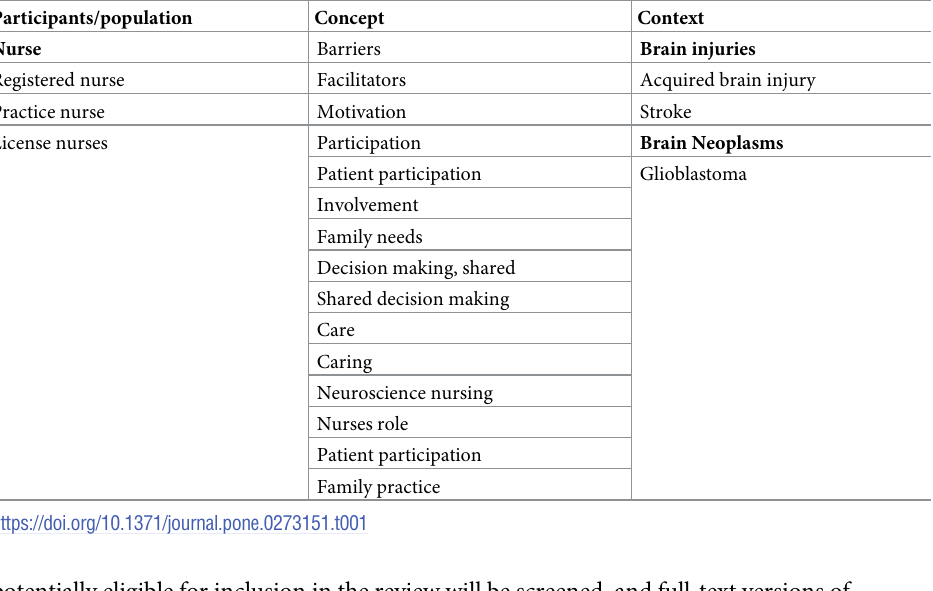
Table 1. Search terms.